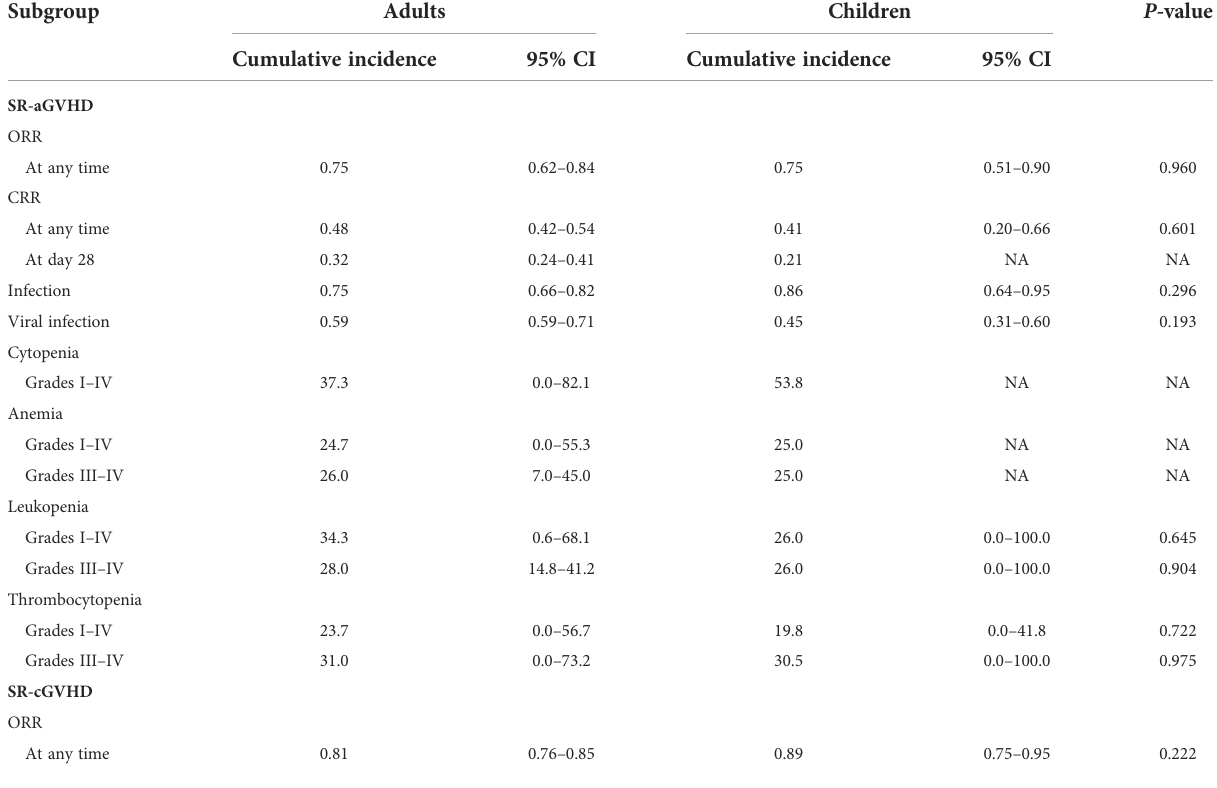
TABLE 6 The summary table of comparisons between adults and